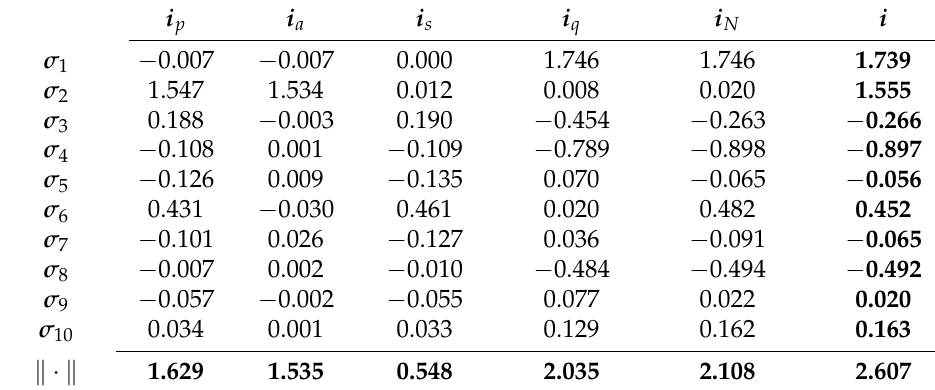
Table 5. Current components obtained from current